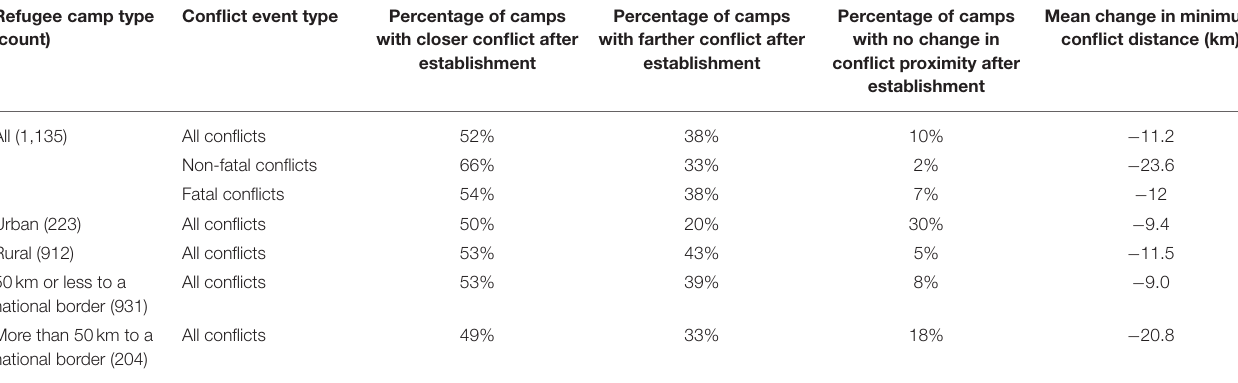
TABLE 4 | Summary of change in conflict event proximity to UNHCR refugee camps after camp establishment (2000–2017). Refugee camp type